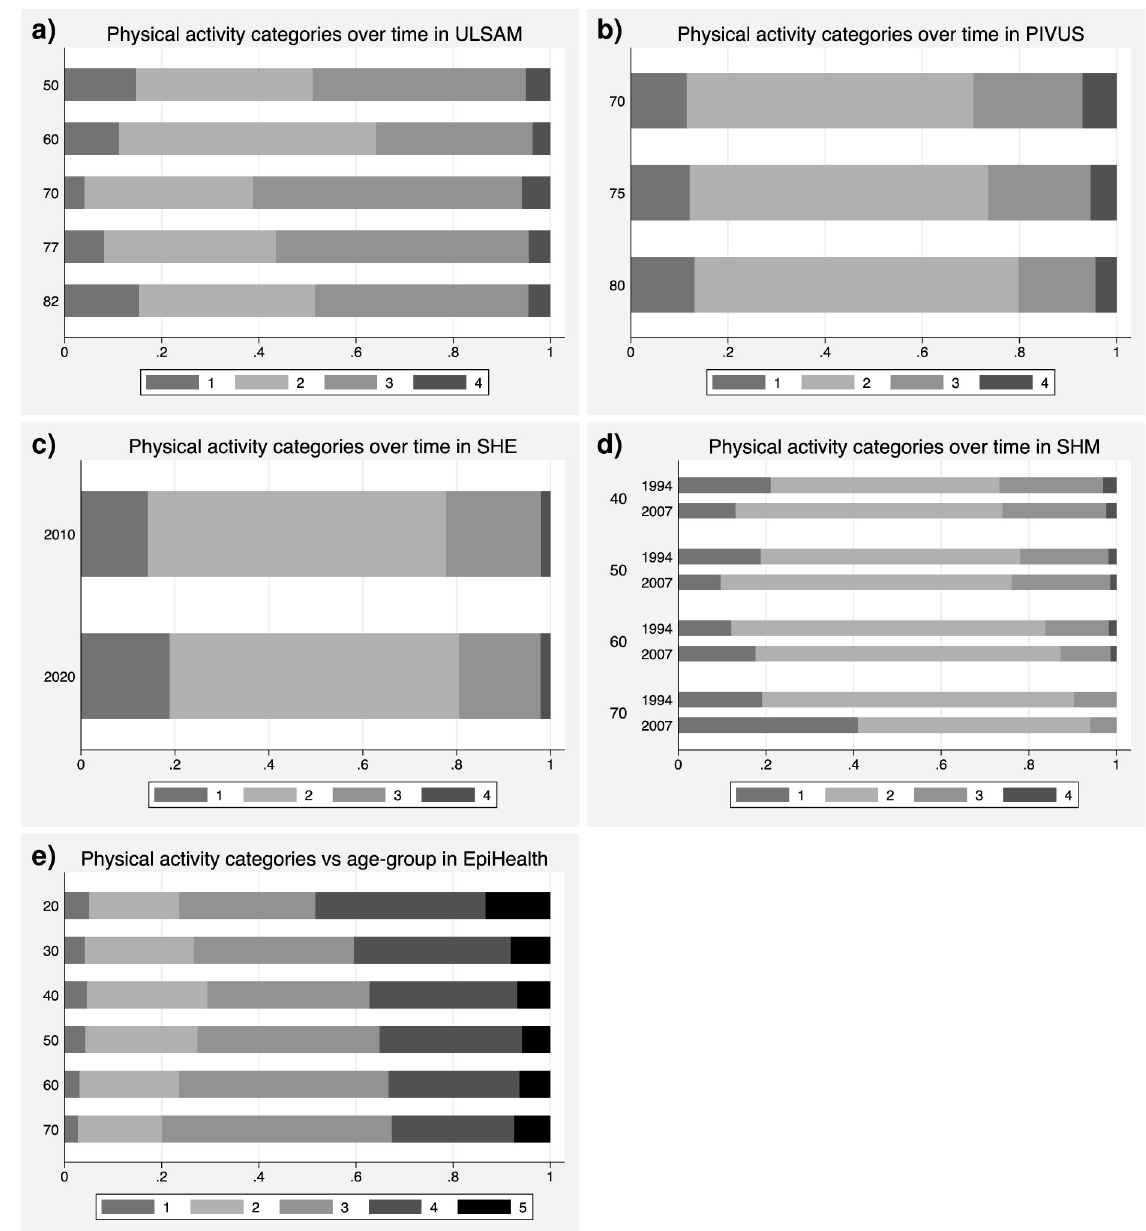
Fig 2. Longitudinal change in physical activity (PA) categories over time in a) ULSAM, b) PIVUS, c) SHE, and d) SHM and cross- sectional relationships between PA categories and age-groups in e) the EpiHealth